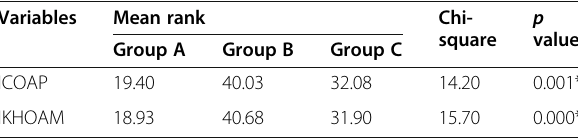
Table 3 Intergroup analysis for pain and functional disability using the Kruskal-Wallis test Variables